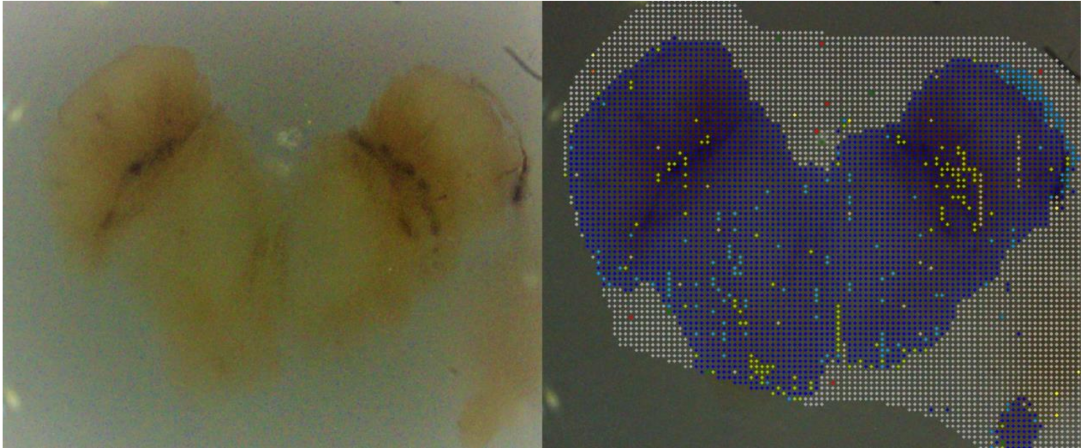
Figure 5. Dermatofluoroscopy of the postmortem substantia nigra pars compacta (SNpc) of a Parkinson patient. The grid above the specimen shows the individual measuring areas; the colored dots indicate the local neuromelanin concentration resulting from the measurements, here for the sake of clarity only as a rough di ff erentiation (blue, no neuromelanin; yellow-green, neuromelanin). Scale 1:5. Examples of two-photon-excited fluorescence spectra of SNpc (i.e., spectra from the individual measurement areas) of deceased non-PD controls are shown in Figure